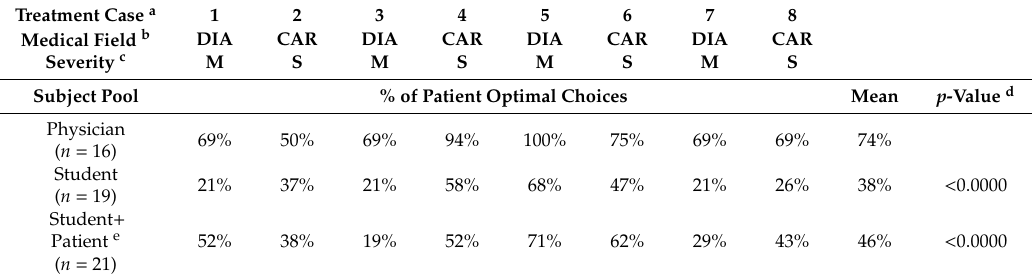
Table 3. Proportions of patient optimal choices by stylized routine cases and subject pool in part 1